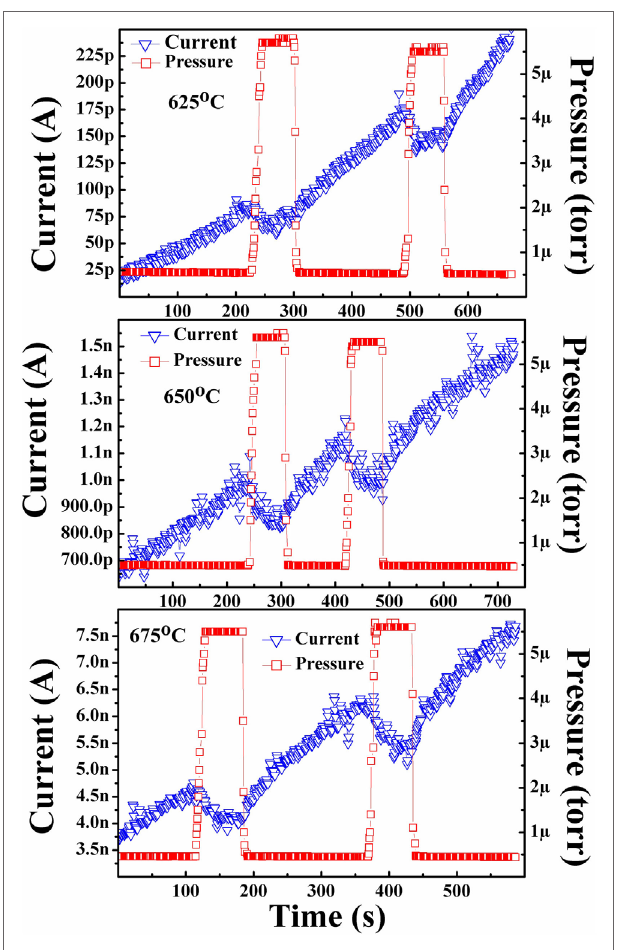
FigUre 5 | Isothermal thermionic emission behavior of an as-grown nitrogen-incorporated diamond cathode in a nitrogen gaseous environment. It can be clearly seen that nitrogen had a negative effect on the emission performance from diamond cathodes which the authors attribute to the decreased mean-free path of electrons traveling from the cathode to the anode.